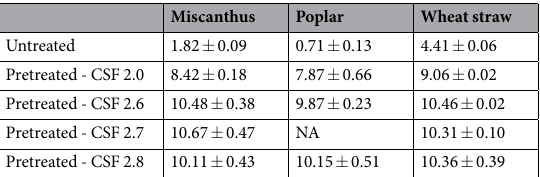
Table 1. Glucose concentration in g/L after a 48-hour saccharification by the Cellic CTec2 cocktail. NA: sample not available. Means and standard deviations are based on measurements done in